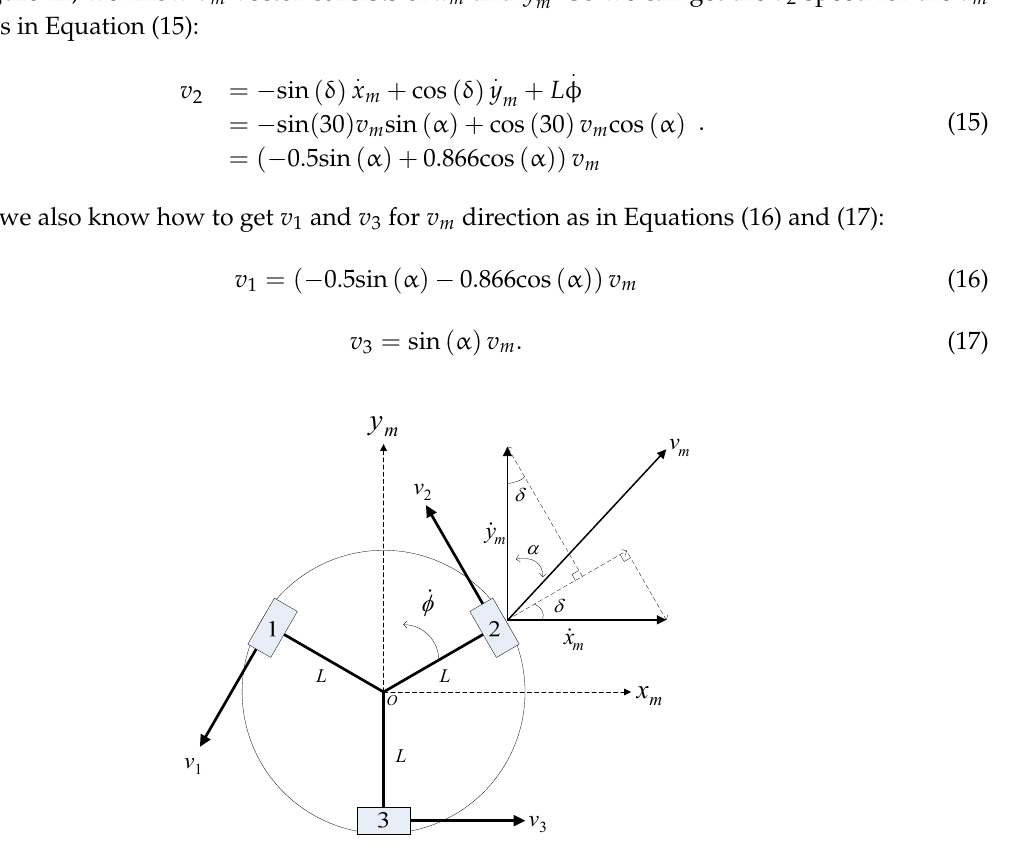
Figure 12. Simplified kinematic model of omnidirectional WMR.